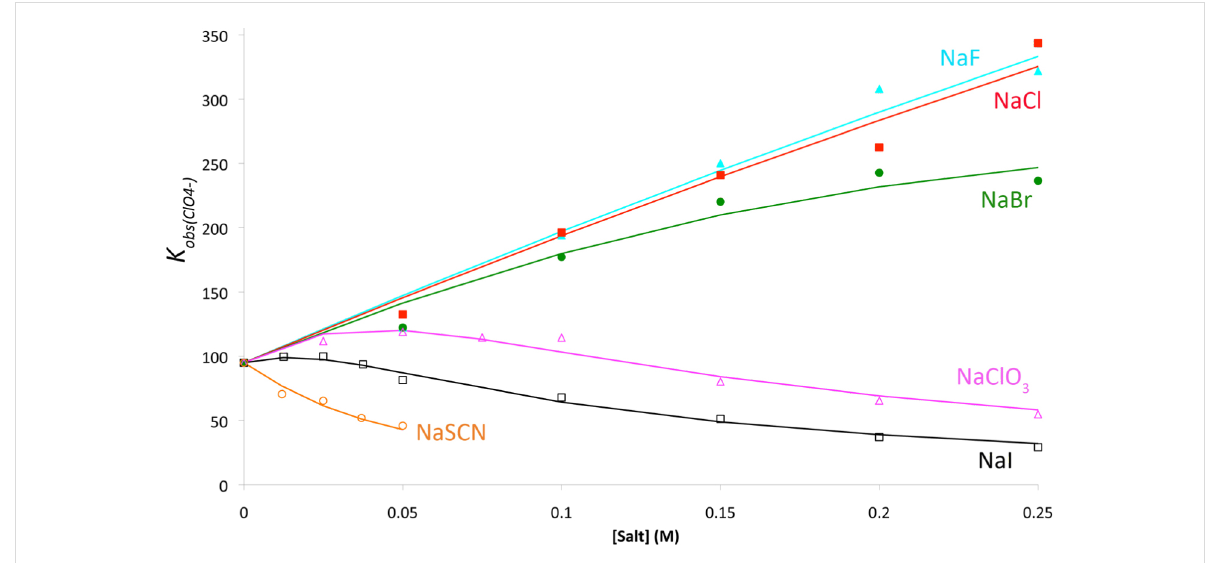
Figure 15: How salts influence the association constant ( K a ) for the binding of ClO 4– to octa-acid (Figure 4). The indicated points correspond to NMR- derived data, whilst the lines correspond to the model devised (see text).